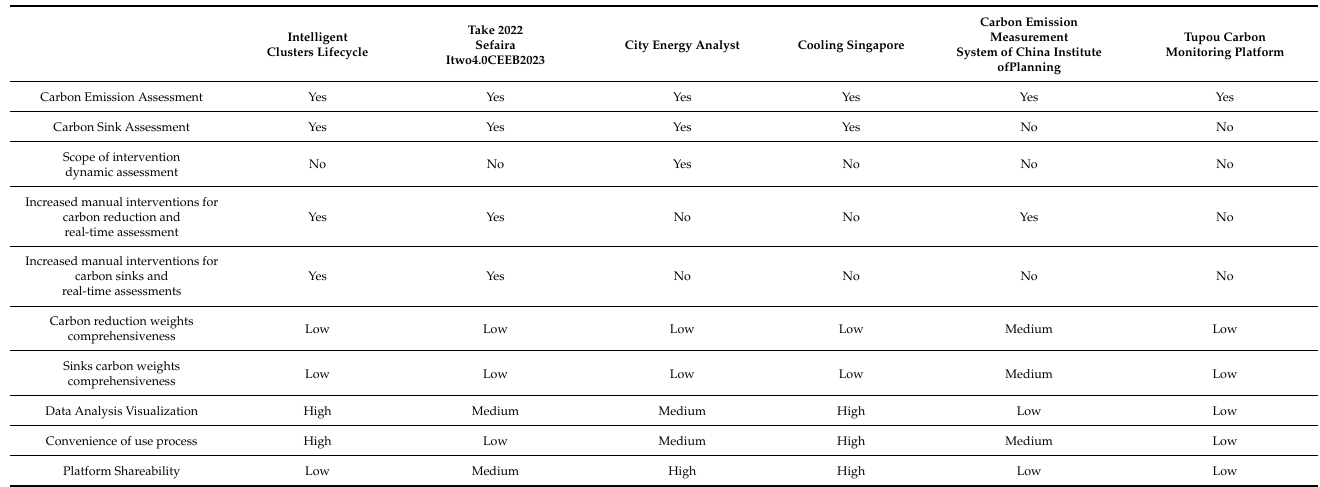
Table 2. Comparison of the functions of existing carbon assessment